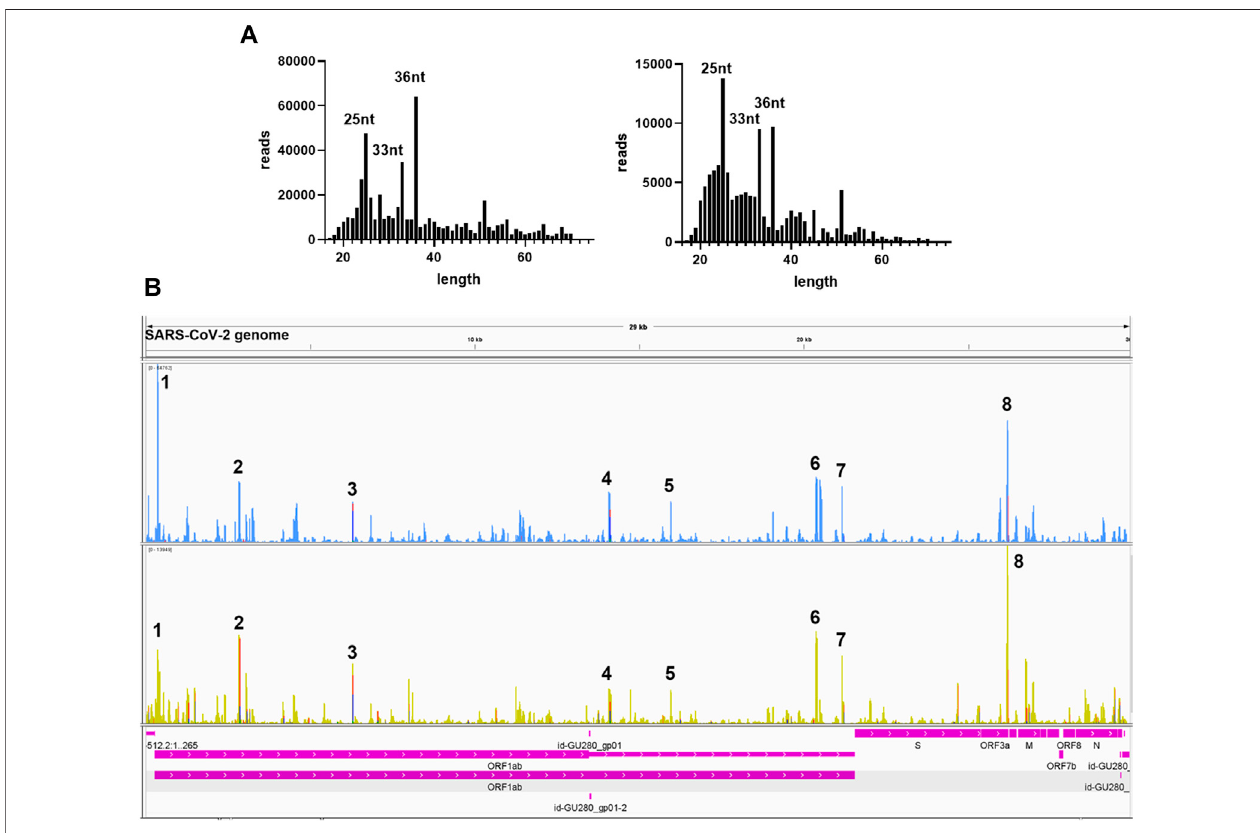
FIGURE 6 | Sequence information of virus-derived sncRNAsA. (A) Length distribution of viral small RNAs from two representative patient samples. (B) Two representative visual inspections of the small RNA sequences aligning with the SARS-CoV-2 genome. The names of viral genes and the genome positions (nt) are